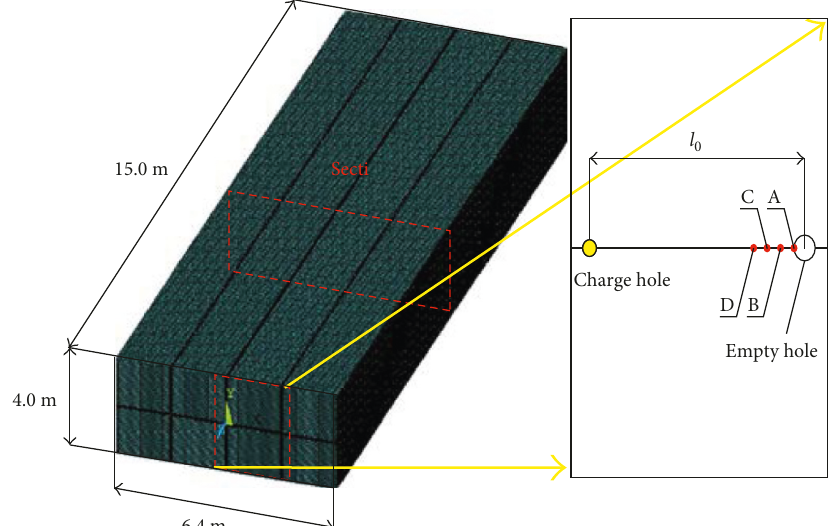
Figure 5: Model boundary and layout of observation points.